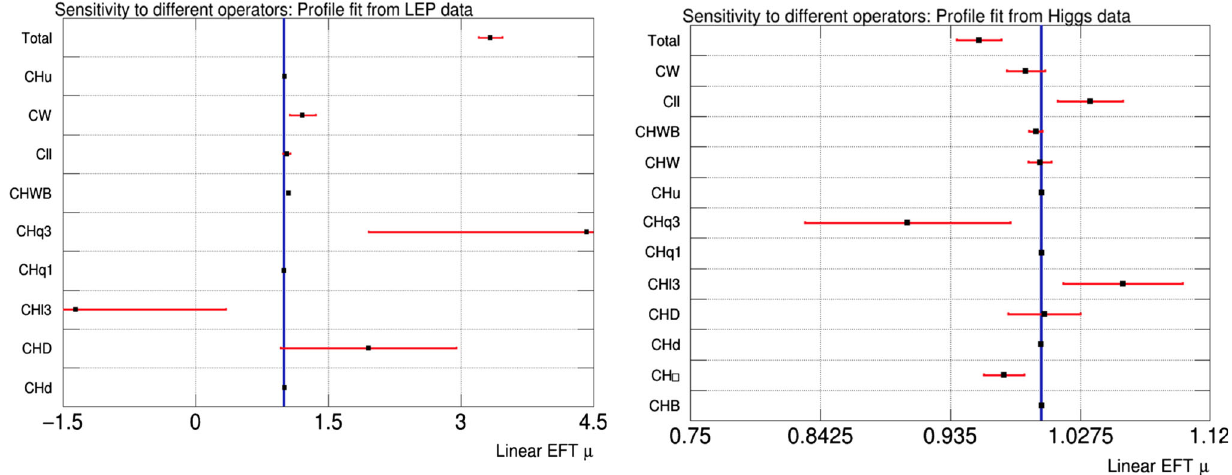
mentioned in the text. The entry “Total” accounts for the combination of the individual entries. In this figure as well as throughout this work we follow the operator nomenclature from Ref. [7] (Table